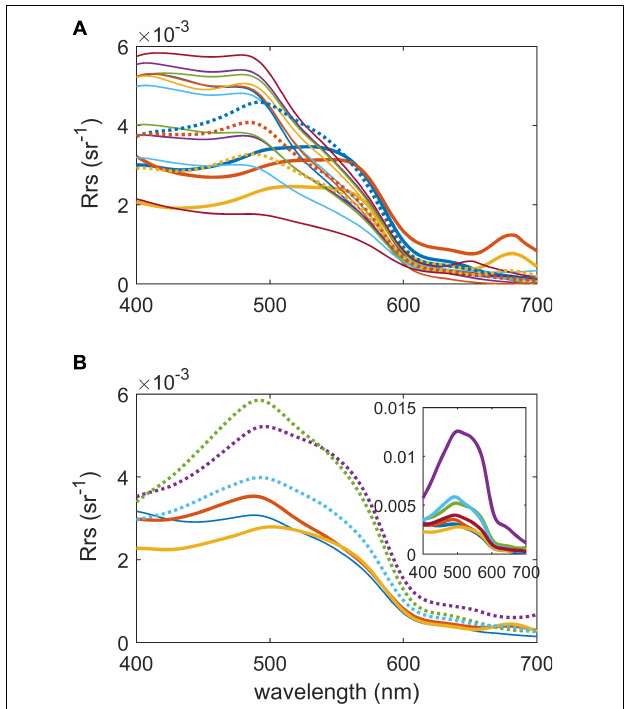
FIGURE 9 | Hyperspectral variability in remote sensing reflectance (Rrs) in the Vaigat-Disko Bay (A) and Godthabsfjord (B) . (A) Rrs spectra measured at stations in the glacial meltwater plume (thin solid lines), at stations with high Chla concentrations (thick solid lines) and with low Chla concentrations (dotted lines). (B) Rrs spectra measured at marine station 3 (thin solid line), in outer fjord (thick solid lines) and in mid fjord (dotted lines). Inset: Rrs spectral variability including spectra of highest magnitude in